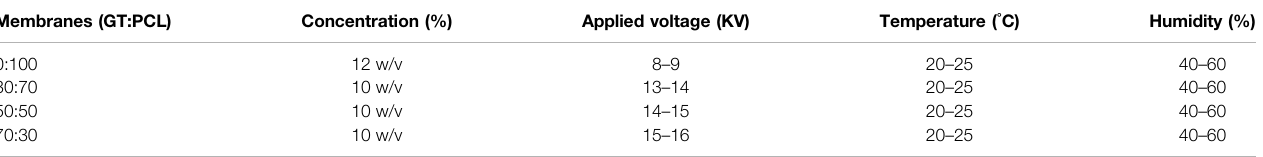
TABLE 1 | Parameters used for electrospinning nano fi brous membranes of GT/PCL. Membranes